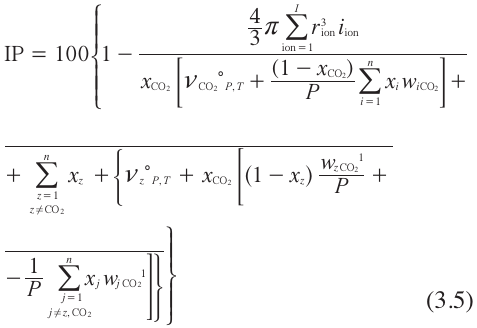
value from eq. (3.5) into eq. (3.3), the helium